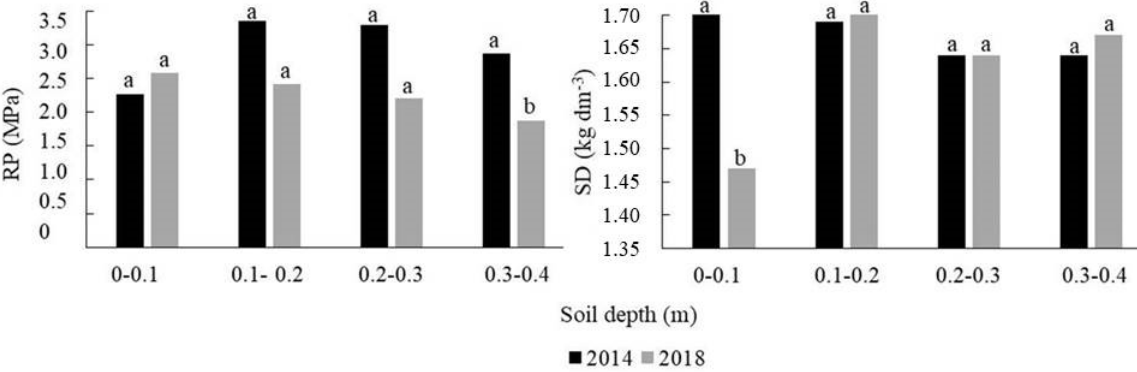
Figure 2. Mean soil resistance to penetration (RP) ( left graph ) and soil bulk density (SD) ( right graph ) at the beginning (2014) and end (2018) of the experiment. Bars with the same letter in the same soil layer are not statistically different from each other by Tukey’s test ( p > 0 .05).